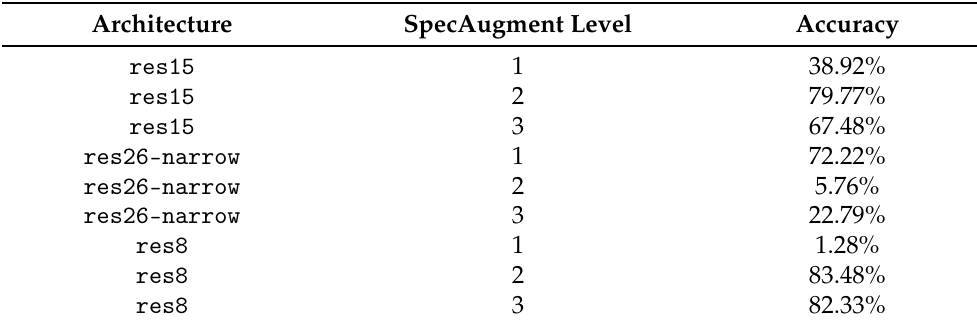
Table 9. Test accuracy of the classifiers pre-trained on the training set of the Lithuanian data set.